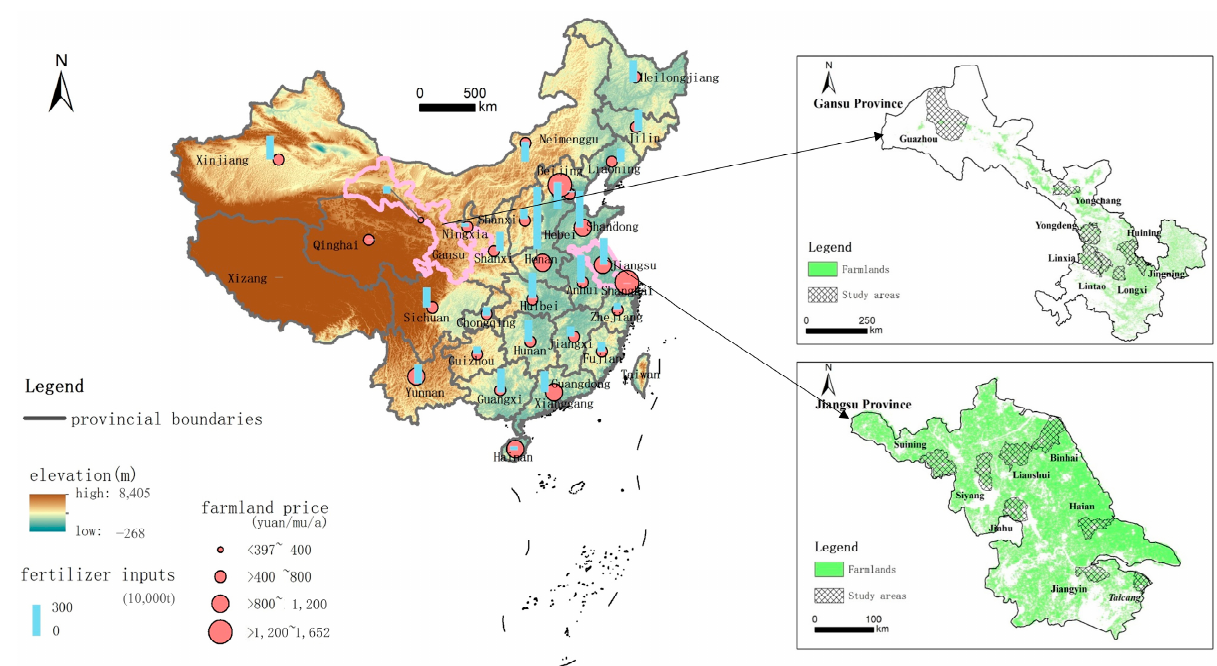
Figure 2. Profile of study areas. Note: Farmland price data were obtained from 41,452 sample sites surveyed by the Ministry of Natural Resources by letter; fertilizer input data were obtained from the Compilation of Information on Costs and Benefits of Agricultural Products in China.